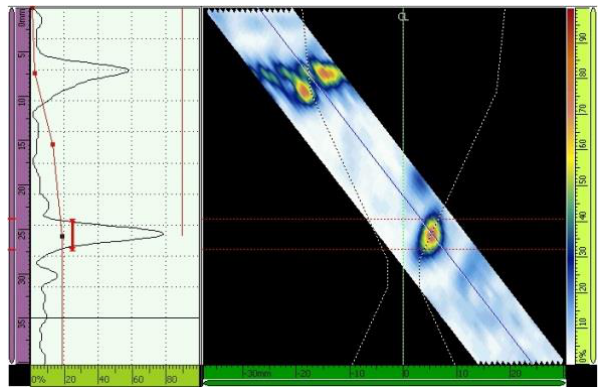
16 active elements. Primary gain = 40.8 dB.